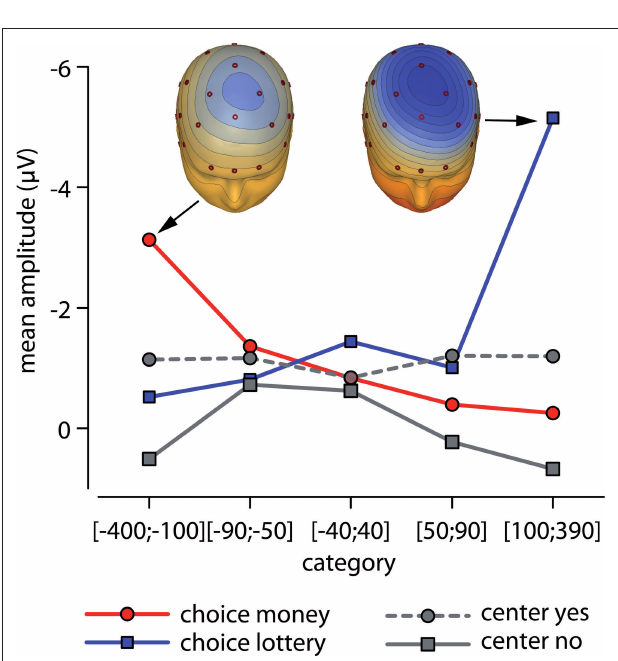
FIGURE 6 | ERN topography. Topographies for the lottery conditions left) choice money [ − 100; − 400] and right) choice lottery [bin 100; 390] are shown. The line graph depicts the mean amplitudes of the response-locked ERPs at CZ per category. Circles referring to “YES”-, squares to “NO”-responses.